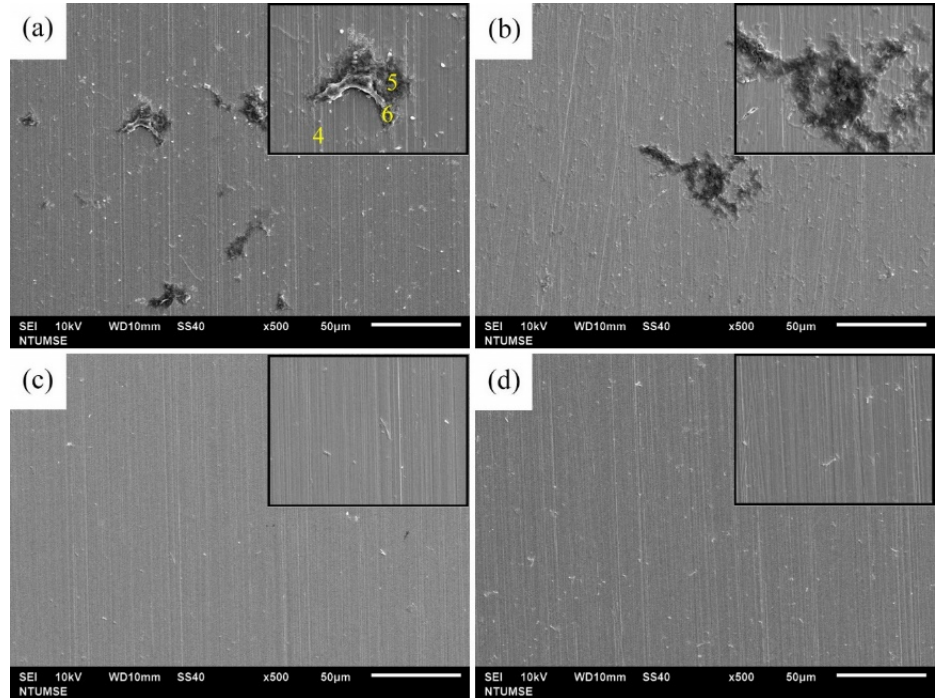
Figure 8. SEM images of the 304 SS surface after 336 h of exposure to ( a ) the uninoculated Tamsui medium, ( b ) TB, ( c ) 3TB, and ( d ) 5TB, presenting enlargements of areas with biofilm formation.